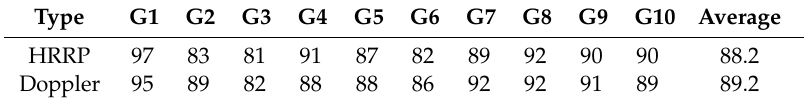
Table 3. Recognition rate with Euclidean distance.